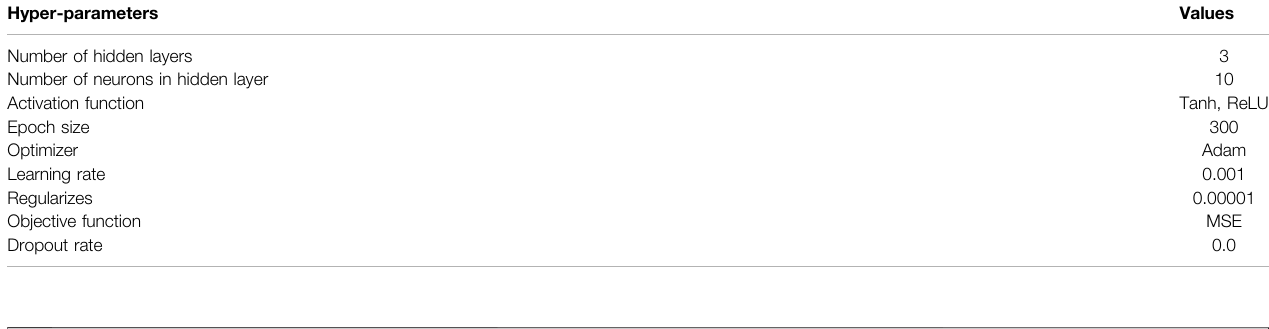
TABLE 8 | Selected ANN model hyper-parameters.